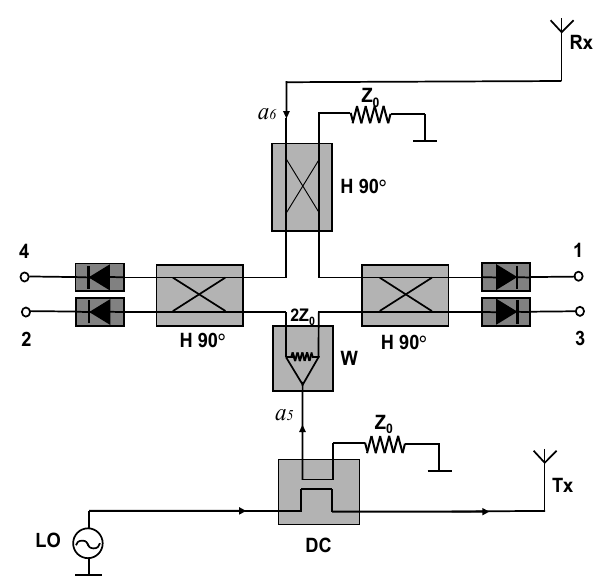
Figure 2. The multi-port interferometer bistatic radar sensor block diagram.